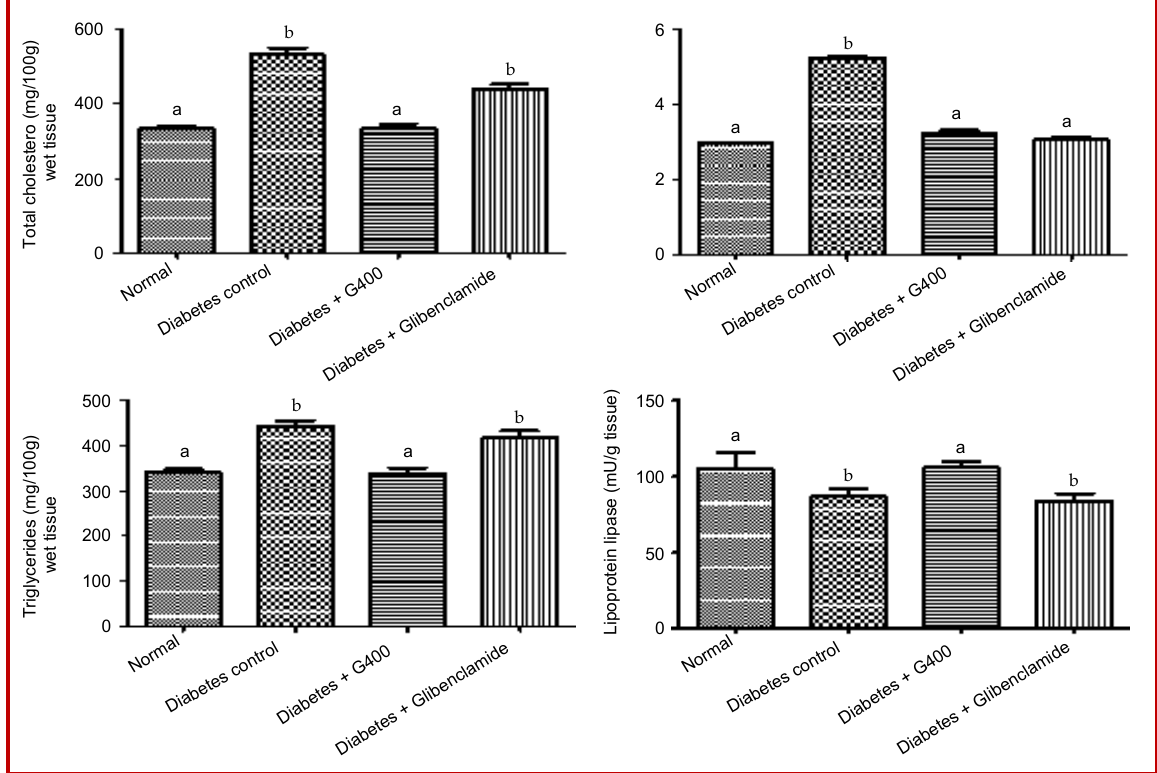
Figure 4: Effect of G-400 on the concentration of total cholesterol and triglycerides and the activities of HMG-Co A reductase in hepatic tissue Streptozotocin-treated diabetic rats were treated with G-400 (100 mg/kg) daily using an intragastric tube for 4 weeks. The results were compared with diabetic control rats (Group 2) and normal control (Group 1), where no streptozotocin was administered. The positive control in the study com- prises of rats administered with glibenclamide (0.025 mg/kg) daily using an intragastric tube for 4 weeks. Results are expressed as mean ± SD of n = 4-6 independent assays. b p<0.05, statistically different from the control group, a p<0.05, statistically different from diabetic